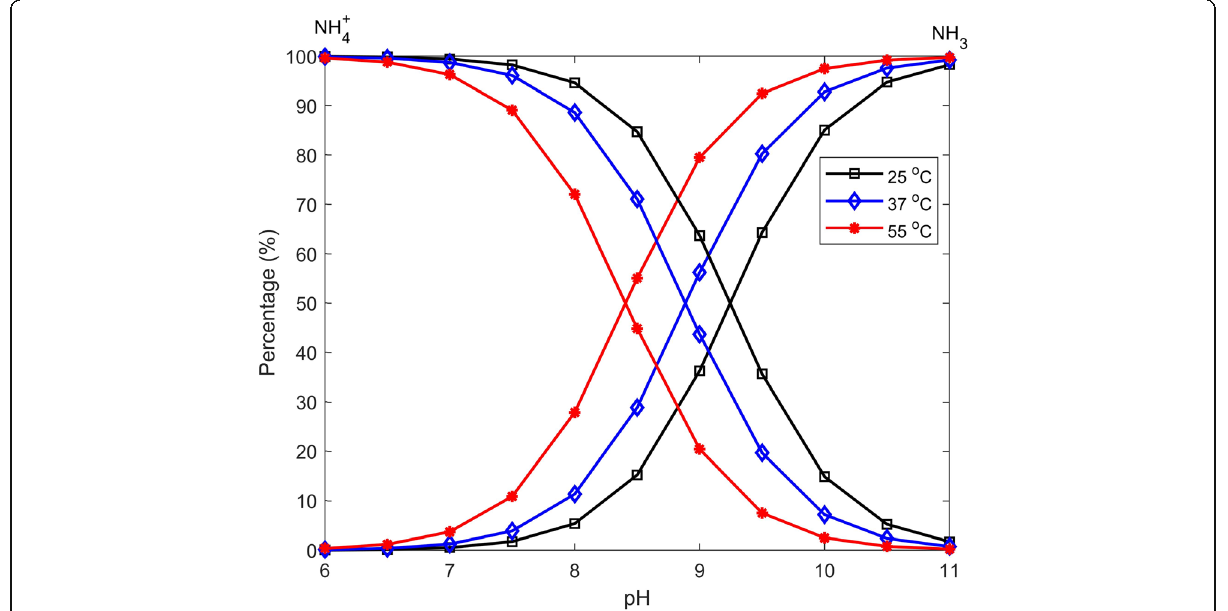
Fig. 2 Variations of un-ionized ammonia and ionized ammonia concentration with pH and